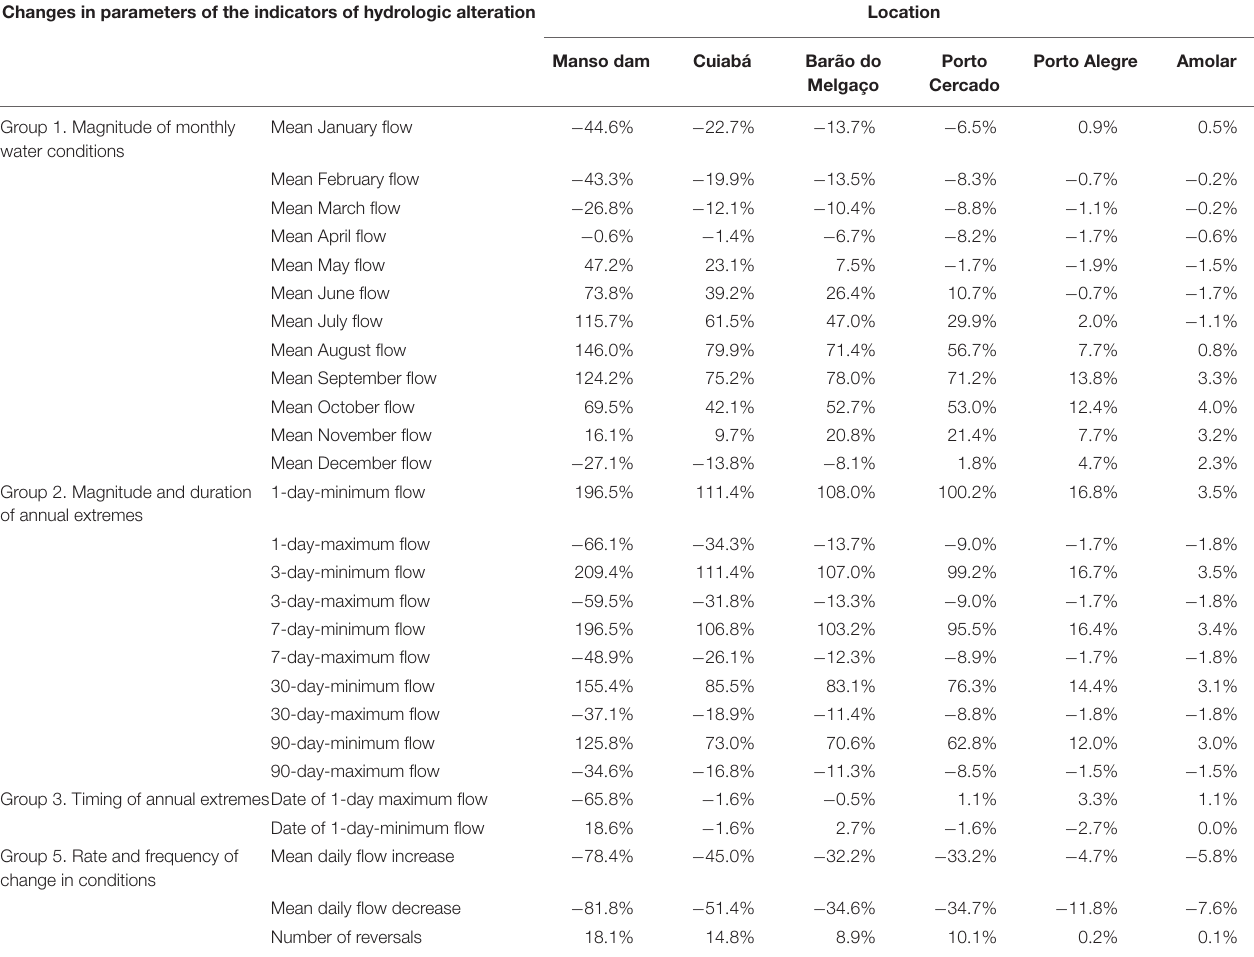
TABLE 3 | Summary of relative changes in average IHA descriptors at reference